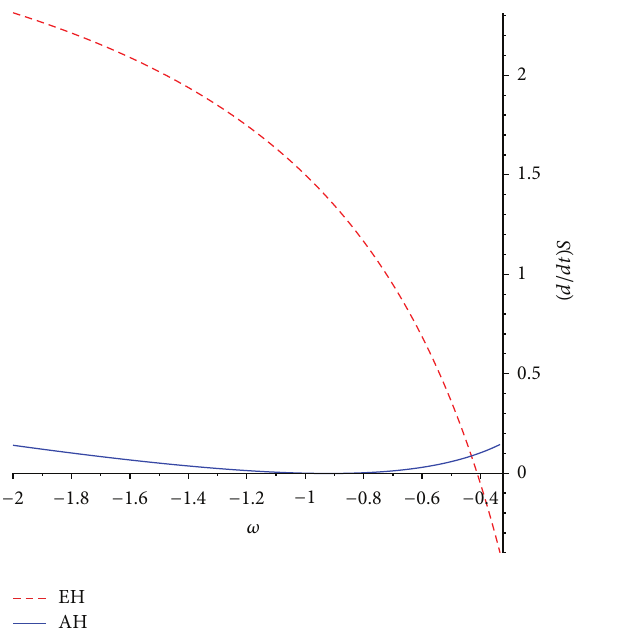
Figure 6: TE for DGP brane for perfect fluid with constant equation of state.